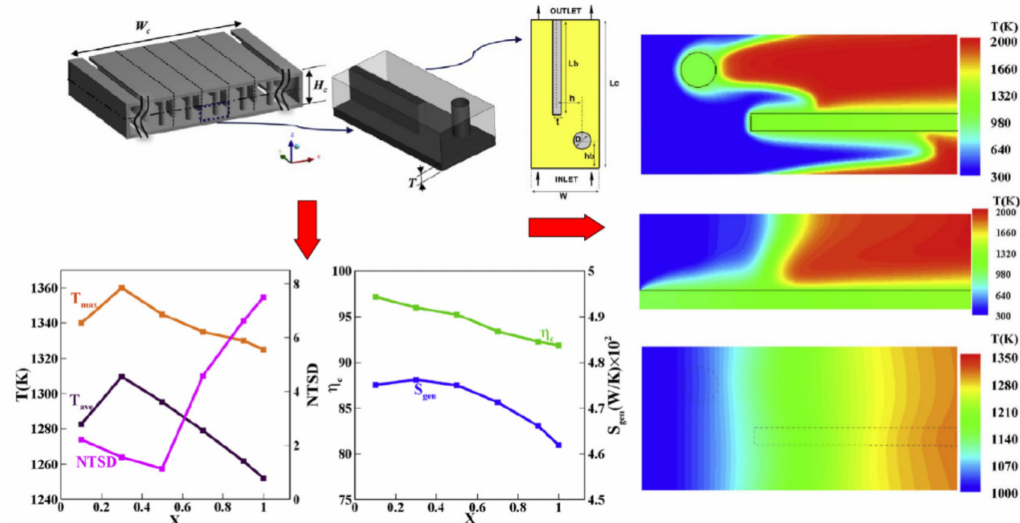
Figure 25. The variations of the average wall temperature (T ave) , maximum wall temperature (T max ), normalized temper- ature standard deviation (NTSD), entropy production (S gen ), and combustion efficiency ( η c ) by the change in methane volumetric fraction